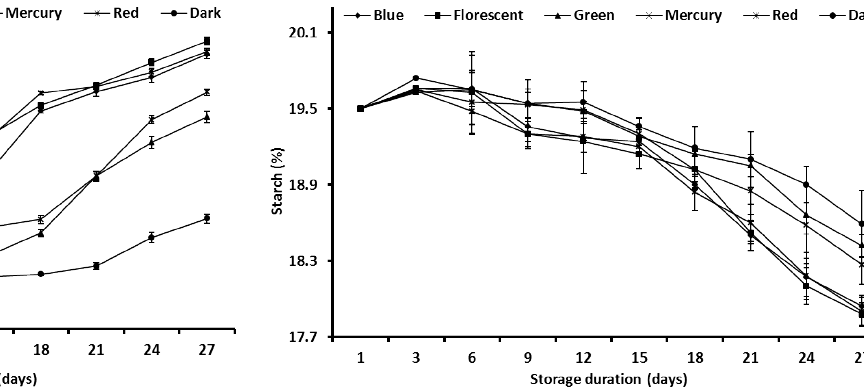
Fig. 1: Effect of different light sources on glucose. Vertical bars show ±SE of means (n=3). The interaction between storage duration and light sources was significantly different at p ≤ 0.05.